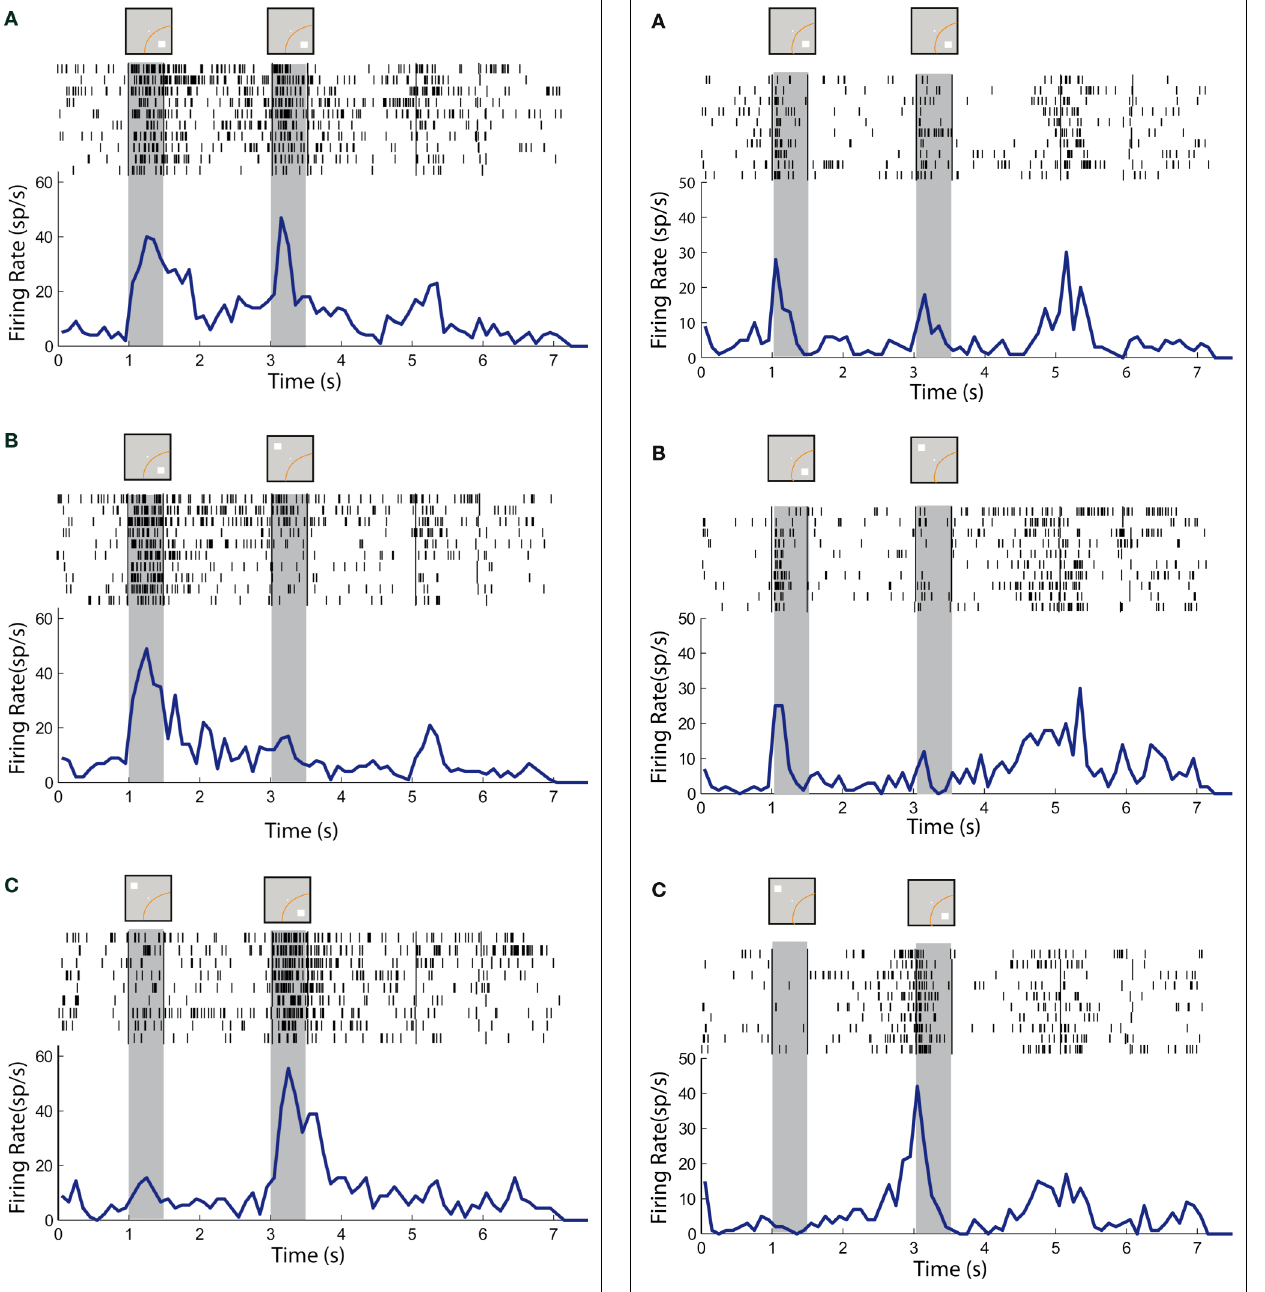
FIGURE 4 | Rasters and histograms of one neuron with anticipatory activity recorded from area 7a of the posterior parietal cortex. Conventions are the same as in Figure 3 . (A,B,C) Responses to the cue followed by a stimulus in the receptive fi eld (A,C) or out of the receptive fi eld (B) , as in Figure 3